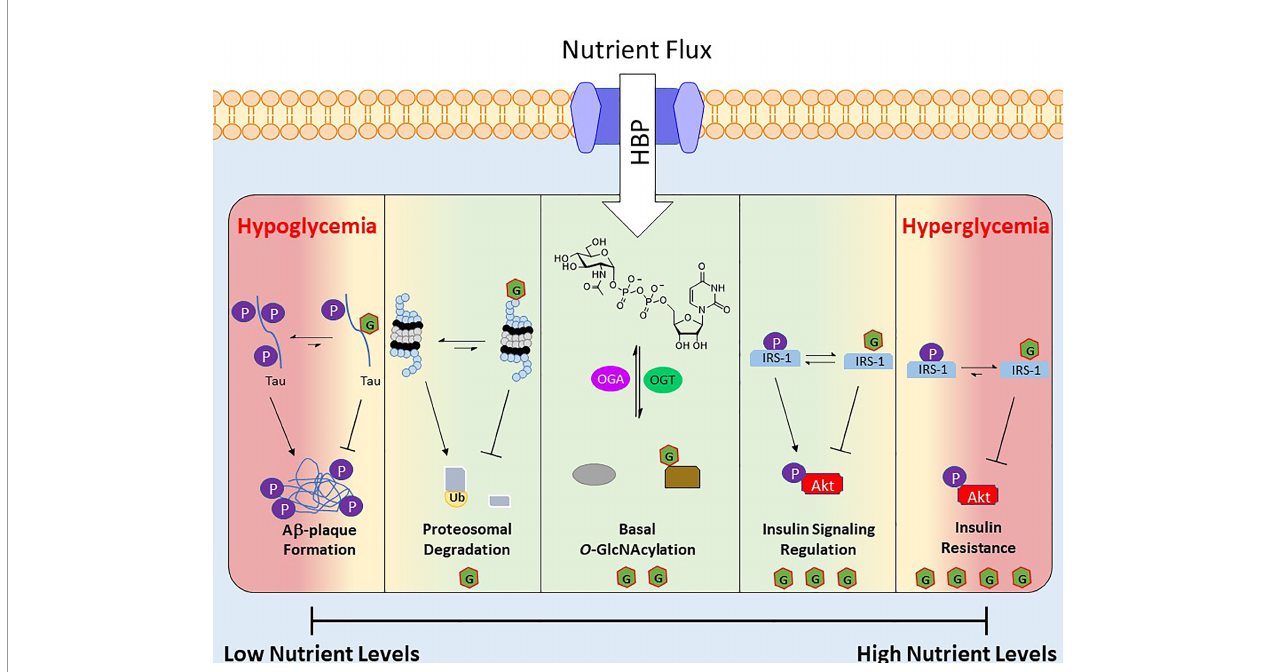
FIGURE 2 | Depiction of O -GlcNAc ’ s role as a nutrient sensing rheostat. Nutrient fl ux directly impacts the levels of UDP-GlcNAc, which regulates the activity and substrate speci fi city of OGT. As a result the O -GlcNAcylated proteins and their corresponding biological functions are a response to the nutrient levels. Below are several examples of O -GlcNAc ’ s effect at various nutrient levels. Green area is “ normal ” effects of O-GlcNAcylation and the red areas are O-GlcNAcylation ’ s effects under extreme nutrient